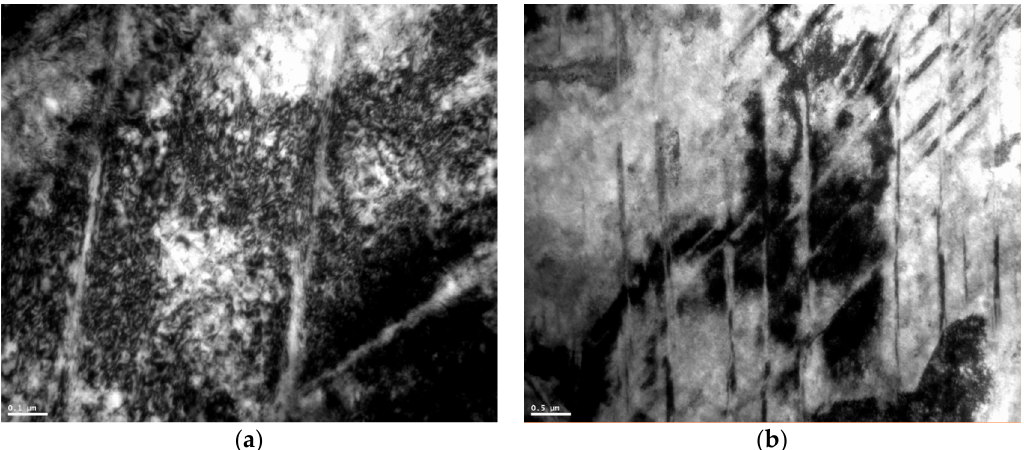
Figure 14. TEM images of a sample deformed until the point of maximum force, highlighting ( a ) the high density of dislocations and ( b ) the deformation twins.